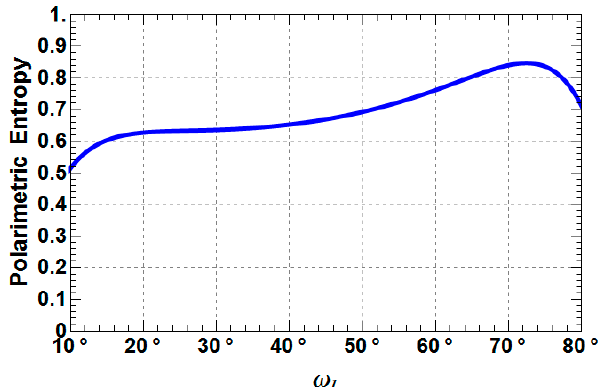
Figure 9. Sensitivity of polarimetric entropy H with local incidence angle ω 1 ( ε s = 20, ε t = 10, L SXD = 1, ϕ = 0°, θ 1 = 60°).